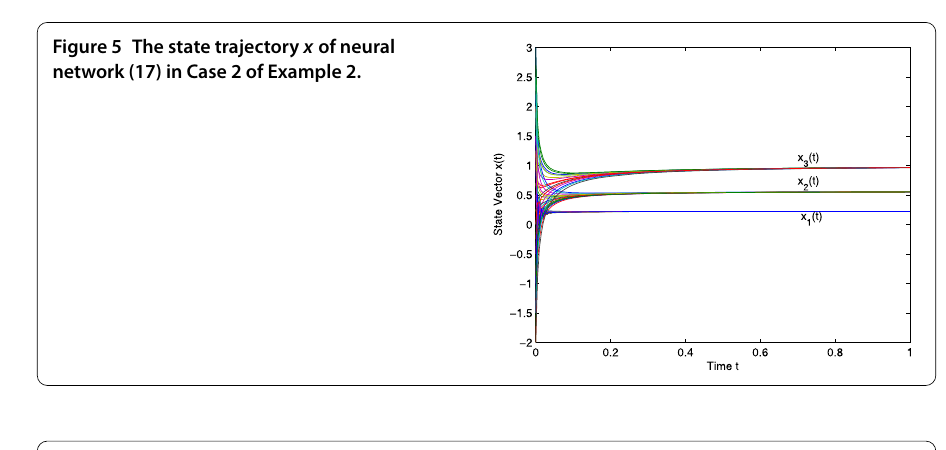
Figure 6 The state trajectory x of neural network (17) in Case 3 of Example